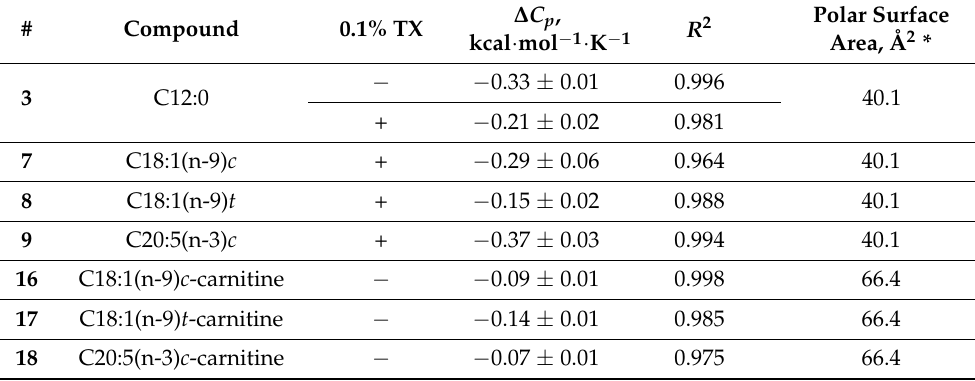
Figure 8. Heat capacity change, Δ C p , and temperature dependence of the binding free energy, Δ G . ( A ) Δ C p values for four fatty acids (FAs) and corresponding acylcarnitines (ACs) binding to heart-type fatty acid-binding protein (FABP3). ( B ) Δ G of FA or AC binding to FABP3 within the temperature range from 0 to 100 °C. Table 2. Comparison of the changes in the heat capacity, Δ C p , for the heart-type fatty acid-binding protein (FABP3)—ligand complexes.